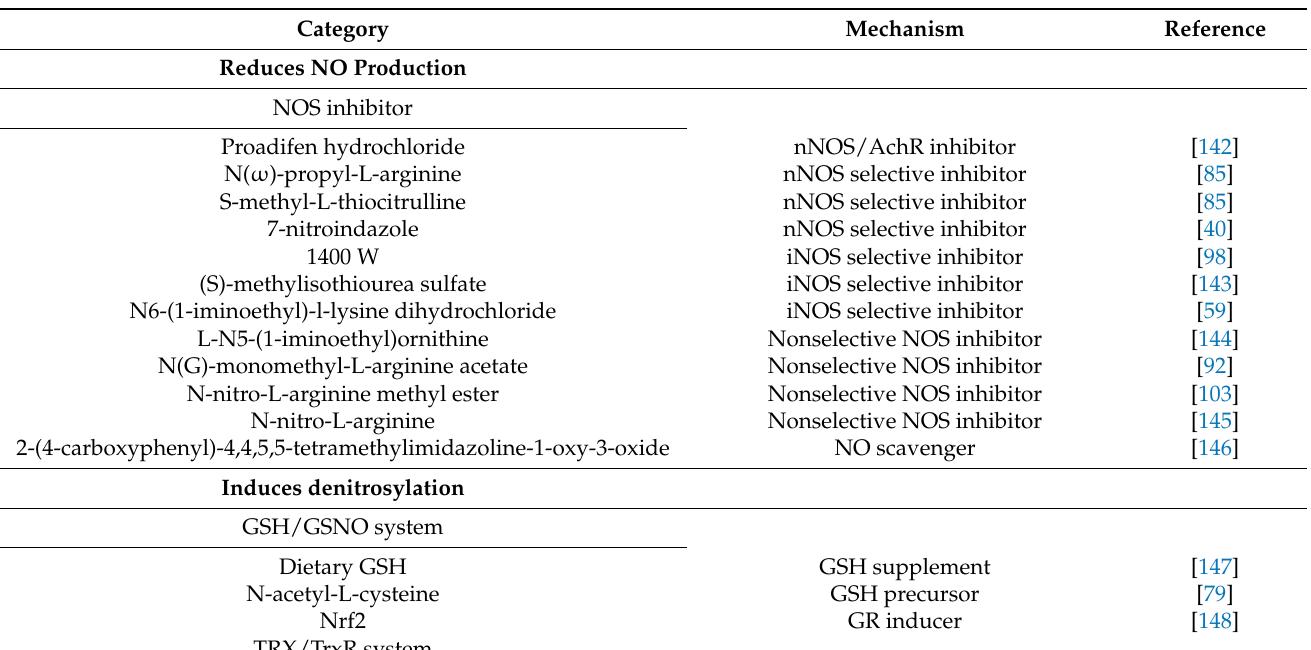
Table 1. Experimental molecules for reducing